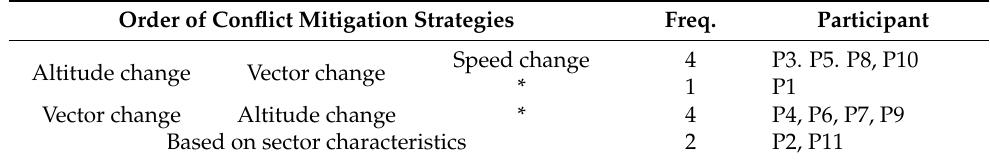
Table 10. Preferred conflict mitigation strategies.